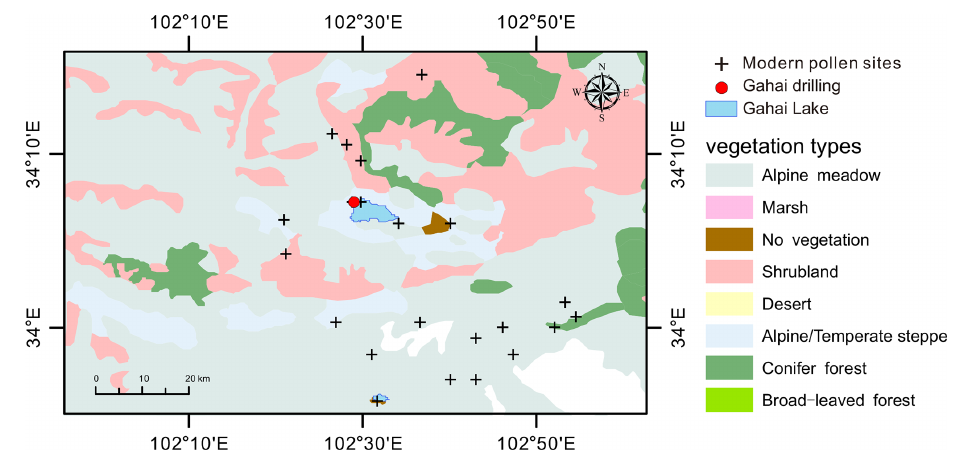
Figure A3. Location of the modern pollen samples ( n = 22) in the vicinity of Gahai Lake.